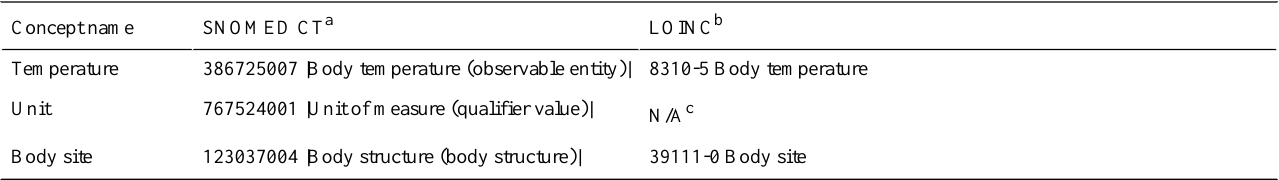
Table 1. Examples of encoded concepts used to describe a temperature